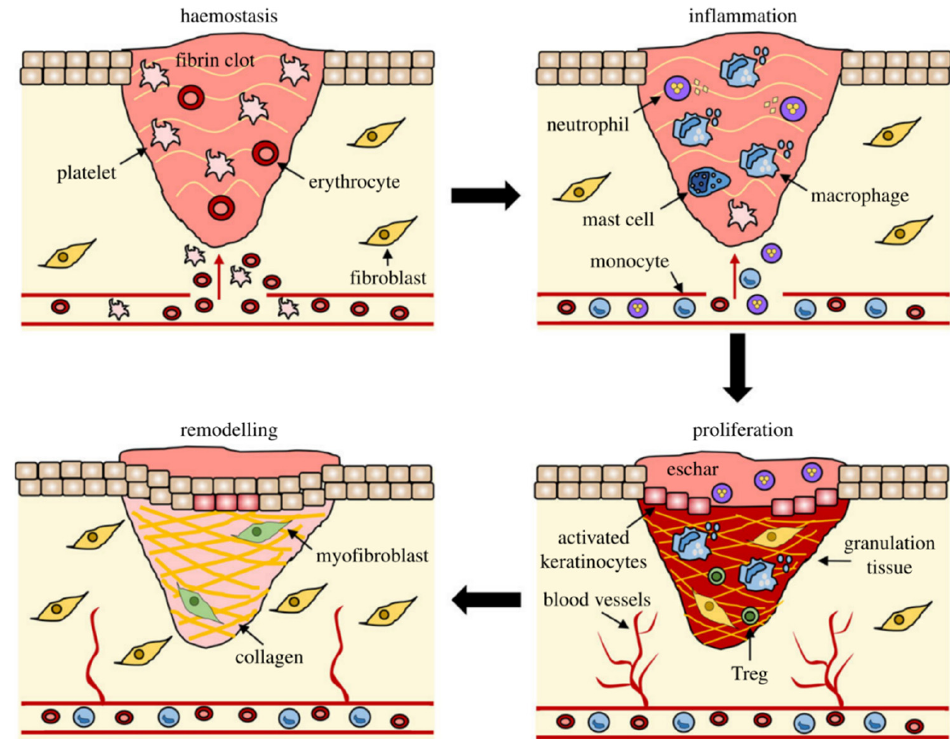
Figure 1. Four overlapping but distinct stages of wound repair healing: hemostasis, inflammation, epidermal regeneration, and scar maturation. Reproduced with permission from Ref. [7]. Published by The Royal Society, 2020.